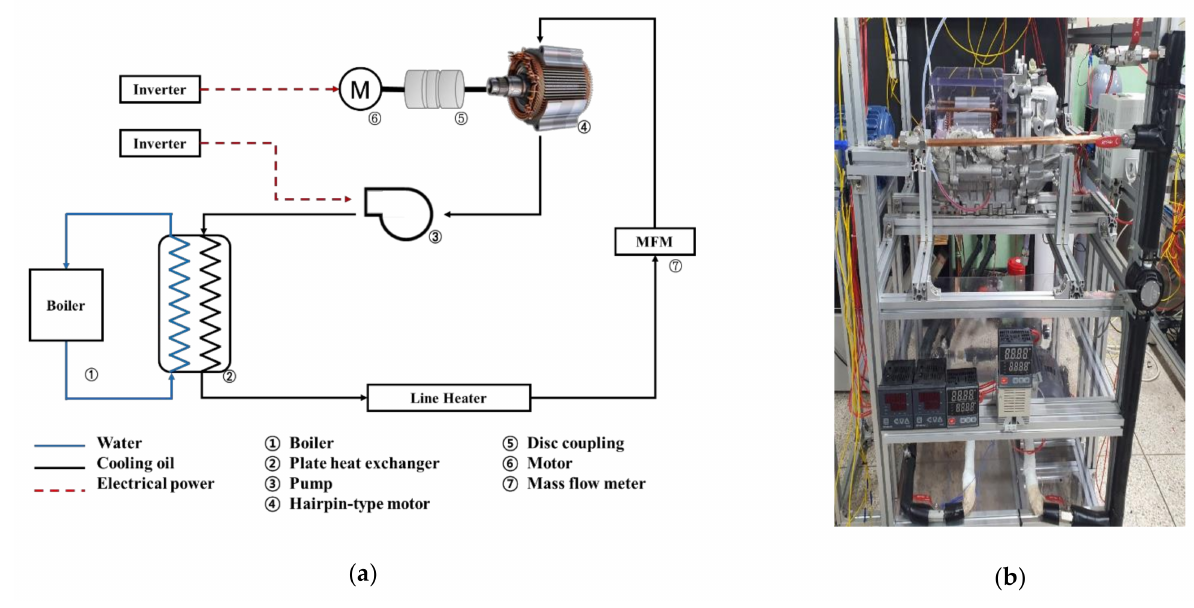
Figure 2. Experimental equipment: ( a ) schematic; and ( b )